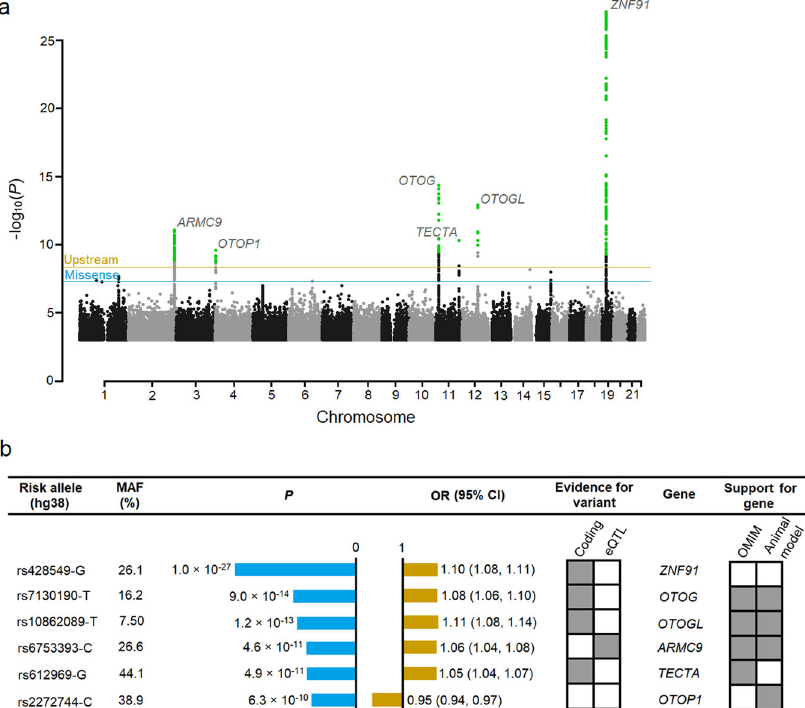
Fig. 1 Variants reaching genome-wide signi fi cance in a meta-analysis of vertigo. a A Manhattan plot showing six genome-wide signi fi cant loci. The horizontal lines represent the adjusted variant-class threshold (blue for missense variants [ P ≤ 4.9 × 10 − 8 ] and orange for upstream variants [ P ≤ 4.4 × 10 − 9 ]). Variants with a P value below their variant-class threshold are marked in green. The – log 10 P values ( y -axis) are plotted for each variant against their chromosomal position ( x -axis). Manhattan and quantile − quantile (Q-Q) plots 66 for each dataset are shown in Supplementary Figs. 2 and 3. b Signi fi cance and odds ratios are shown for the combined analysis (see Fig. 3 and Supplementary Data 1 for association results for each dataset). Support for gene, where OMIM entry or animal studies support the implication of the genes in vestibular functions can be seen in detail in Table 1. MAF minor allele frequency, eQTL expression quantitative trait loci, OR odds ratio, CI con fi dence interval.